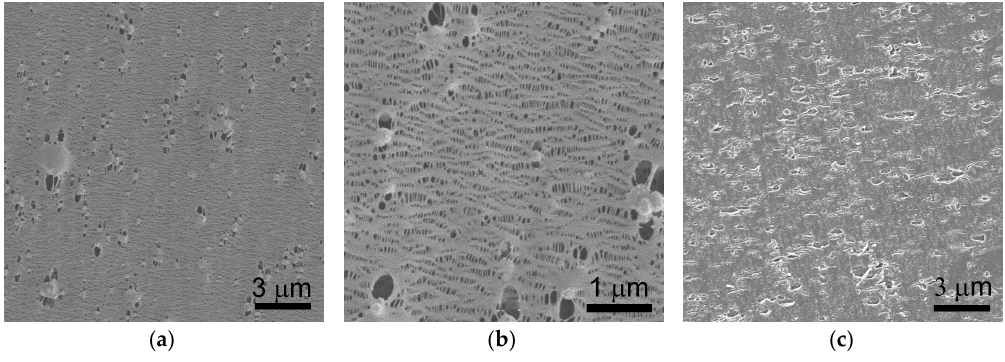
Figure 5. ( a , b ) Surface and ( c ) cross-section morphologies of PP/TiO 2 composite membranes with 40 wt % TiO 2 .